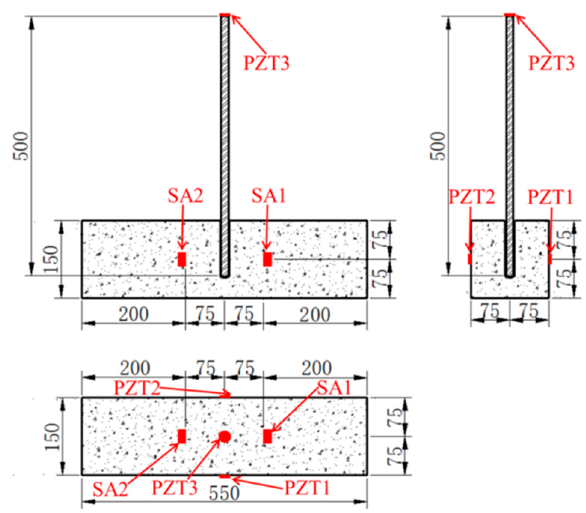
Figure 3. Dimensions of the specimen and the location of PZTs and SAs